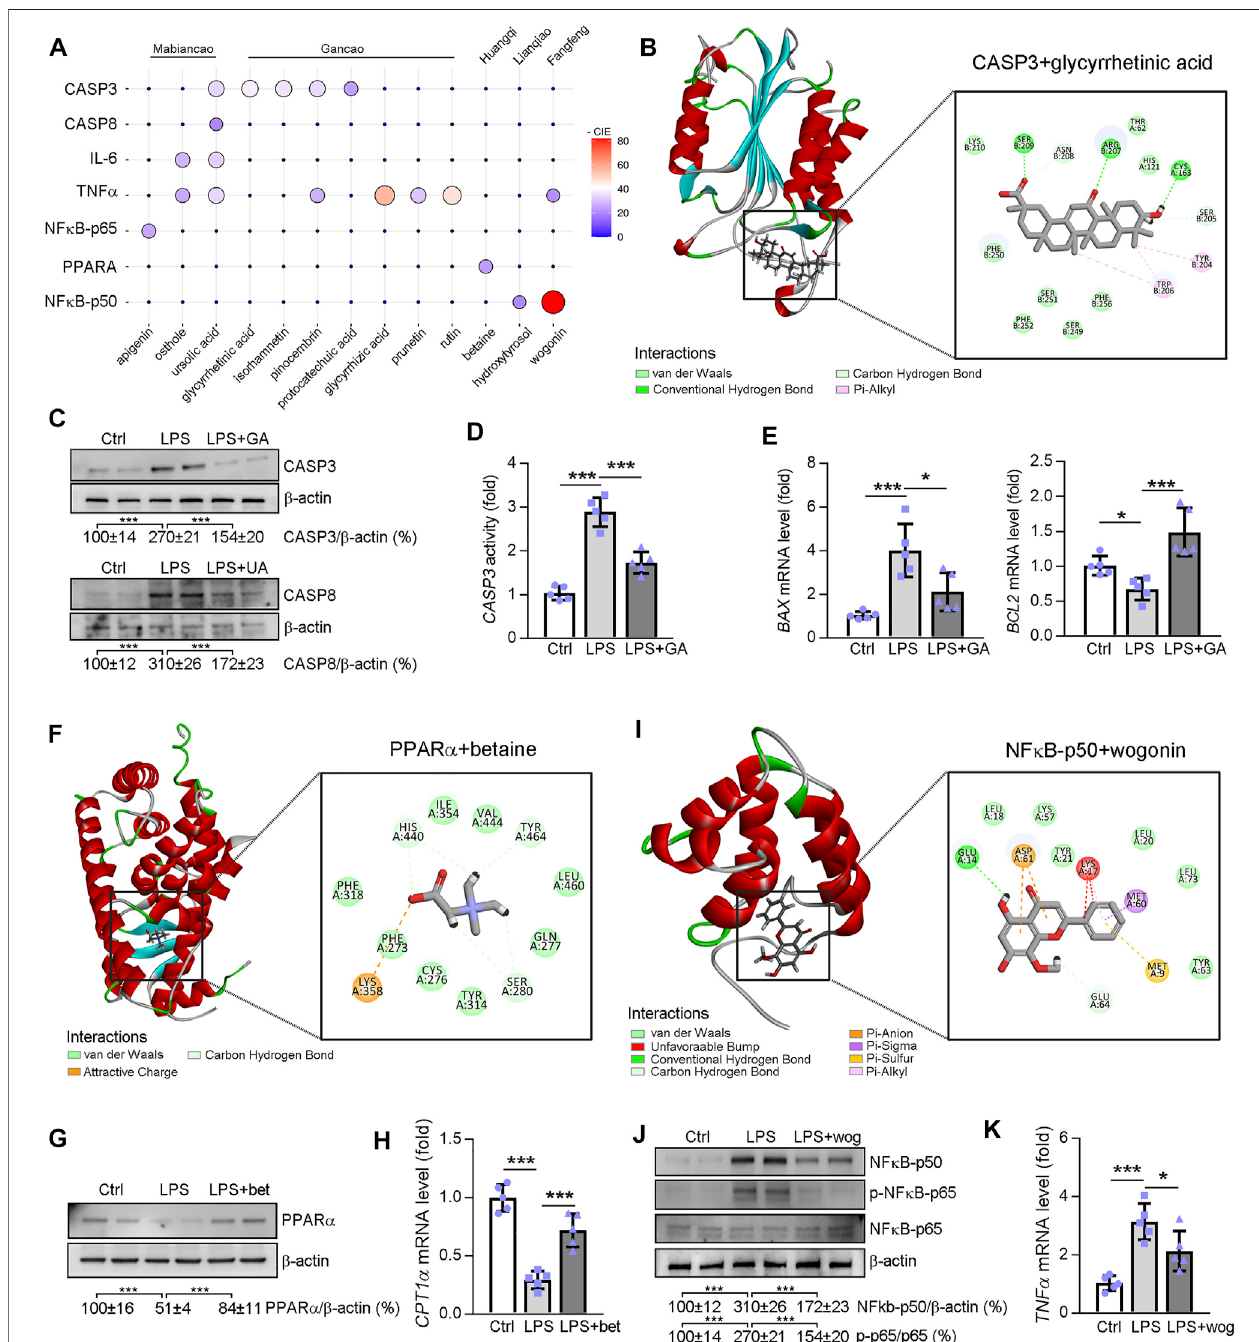
FIGURE 8 | Molecular docking between the potential molecule targets and the compound analyzed by network pharmacology. (A) The ggballoon plot demonstrates the degree of interaction between Ganweikang ’ s potent small molecule compounds and the receptor proteins. The strength of the -CIE is shown by the sizeandcolorofthecircles.0meansthattherelationshipbetweentheactiveingredientsandtheproteinshasnotbeenpredictedbytheHERBdatabase(http://herb.ac. cn/). (B) Molecular docking of glycyrrhetinic acid and CASP3. (C) Western blotting demonstrates the protein level of CASP3 and CASP8 in HepG2 cells after indicatedtreatment, n =3. (D) Casp3activityinHepG2cellswasdeterminedbythecommercialkit, n =5. (E) TranscriptionalexpressionofBAXandBCL2inHepG2cells after indicated treatment was determined by qRT-PCR, n = 5. (F) Molecular docking simulations of betaine and PPAR α . (G,H) After indicated treatment, expression of PPAR α and CPT1 α in HepG2 cells was determined by Western blotting and qRT-PCR, n = 5. (I) Molecular docking simulations of NF κ B-p50 and wogonin. (J,K) After indicatedtreatment,expression ofNF- κ B-p50,NF- κ B-p65,p-NF- κ B-p65,andTNF α inHepG2cellswasdeterminedbyWesternblottingandqRT-PCR,n=5.* p < 0.05, *** p < 0.001, by one-way ANOVA with Bonferroni